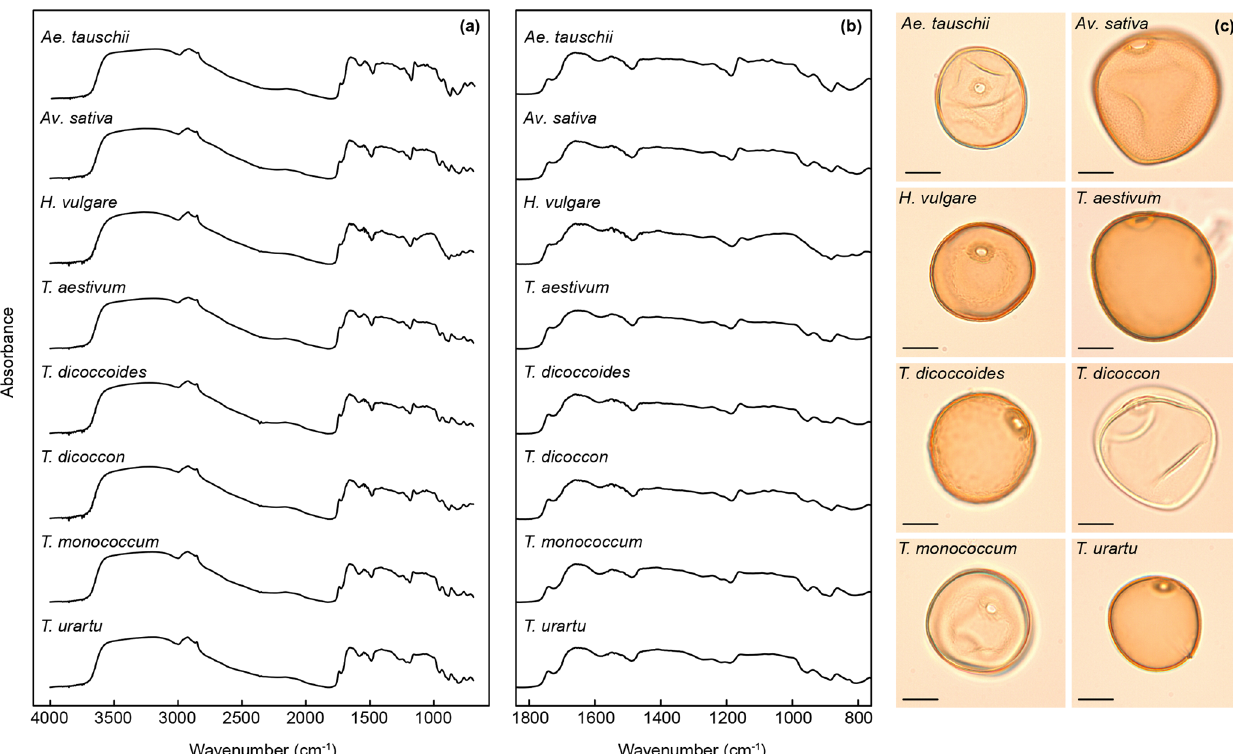
Figure 2. FTIR spectra showing the mean spectrum for each species across (a) the entire 4000 to 690cm − 1 range analysed and (b) the 1800 to 800cm − 1 region. See Fig. S1 for derivatised spectra. (c) Photographs of analysed grass species; scale bars are